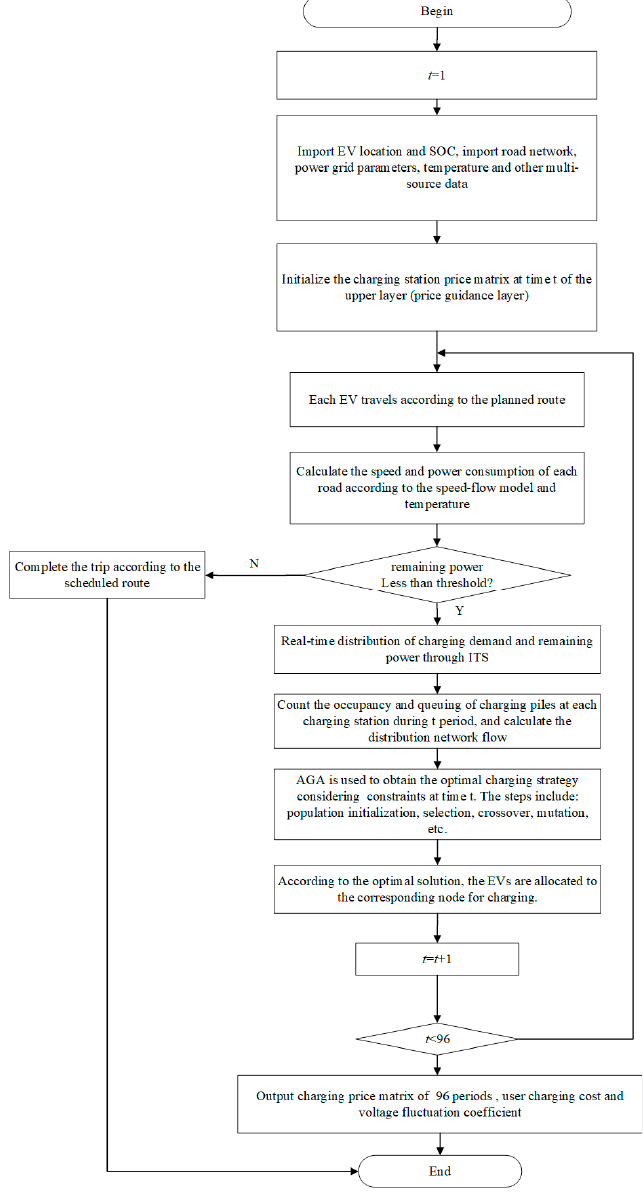
Figure 8. Collaborative optimization strategy calculation process.